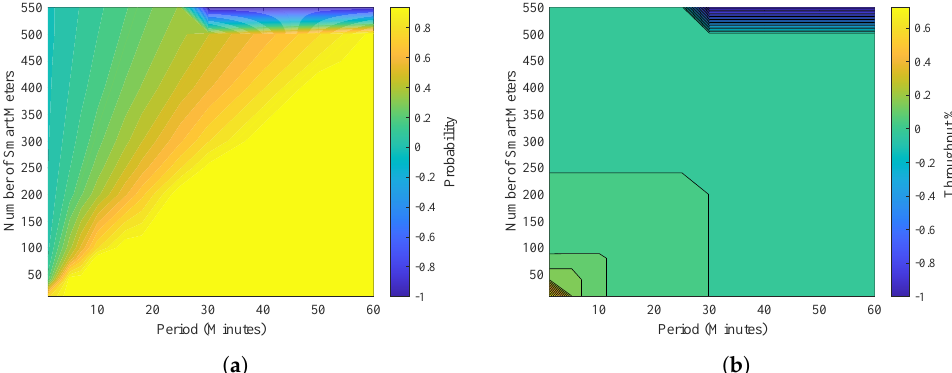
Figure 7. Impact of the number of smart meters to receive a free channel. ( a ) Relationship between # of smart meters and their probability of reading over time; ( b ) relationship between # of smart meters and throughput over